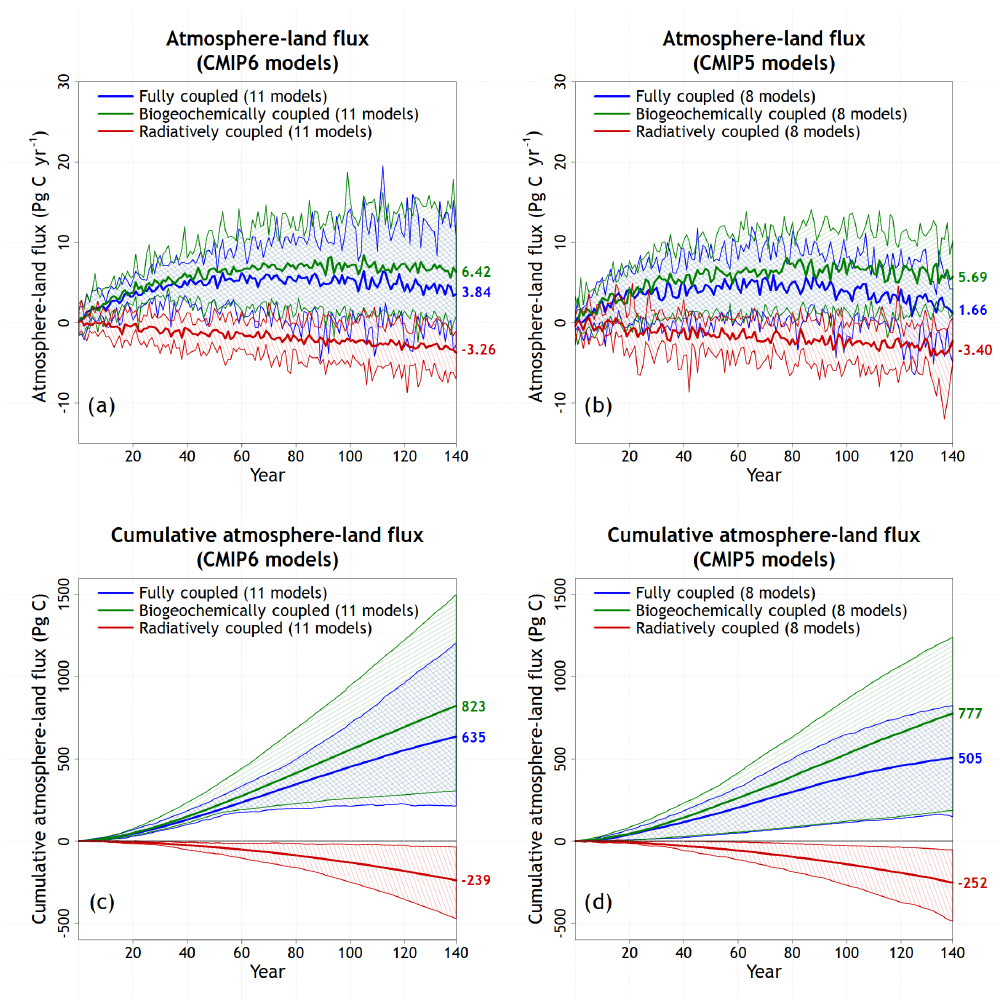
Figure 2. Model mean values and the range across models for annual simulated atmosphere–land CO 2 flux (a, b) and their cumulative values (c, d) for participating CMIP6 (a, c) and CMIP5 (b, d) models from the fully, biogeochemically, and radiatively coupled versions of the 1pctCO2 experiment. Individual CMIP6 model results are shown in Fig.